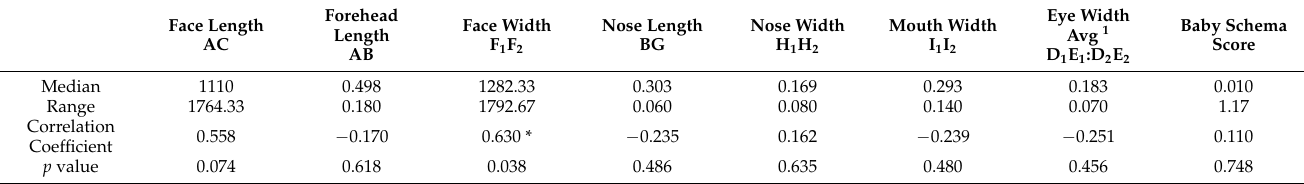
Table 2. Results from Spearman’s rank-order correlation of subjective cuteness ratings and subset of images (n = 12), measured using the Glocker et al. [16]